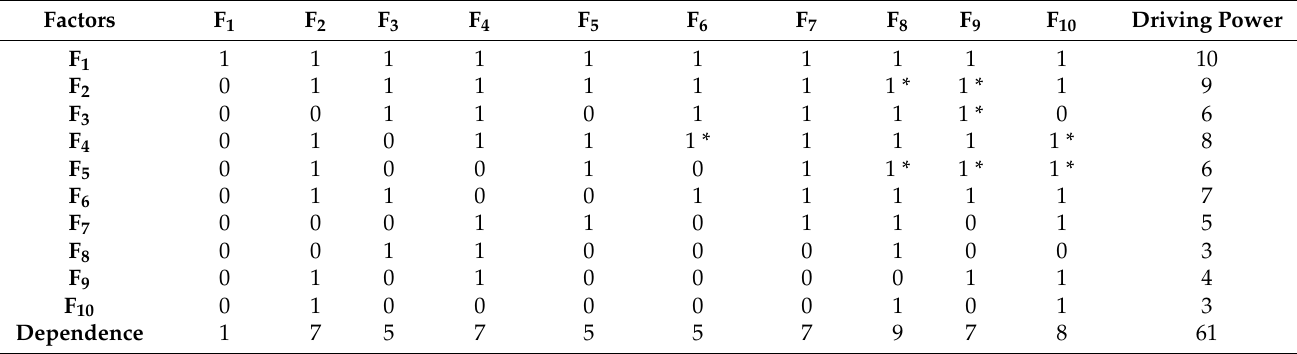
Table 10. Final reachability matrix.